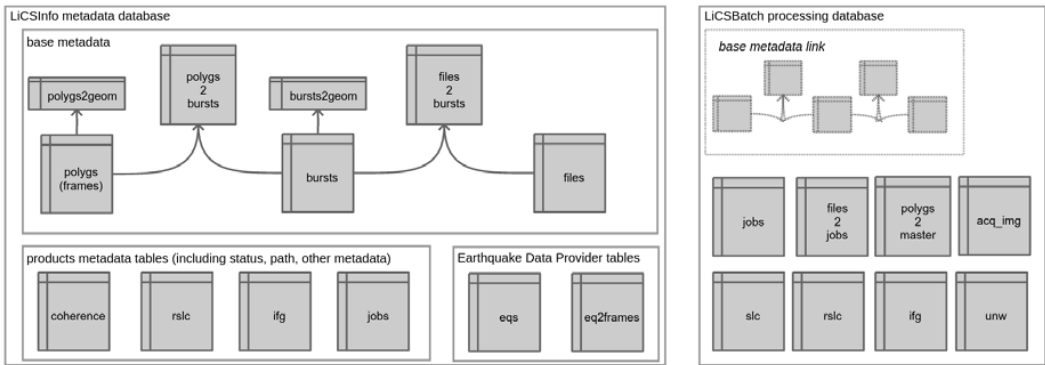
Figure 4. Base structure of LiCSAR databases—LiCSInfo metadata database for storing information on burst and frame definitions, related input files and output products, and earthquake frame data ( left ) and LiCSinfo batch processing database for storing temporary information used for LiCSAR FrameBatch processing chain ( right ).